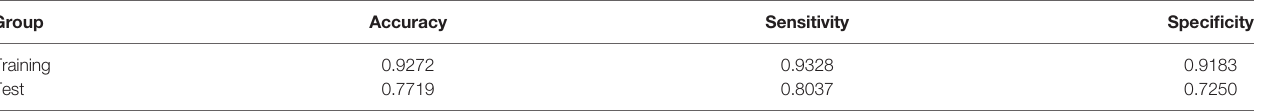
TABLE 6 | Integrated model veri fi cation